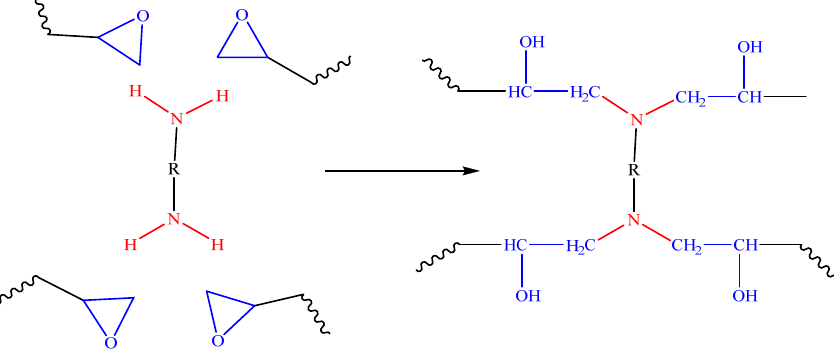
Figure 2. A proposed mechanism of the reaction of an epoxy resin with a diamine.